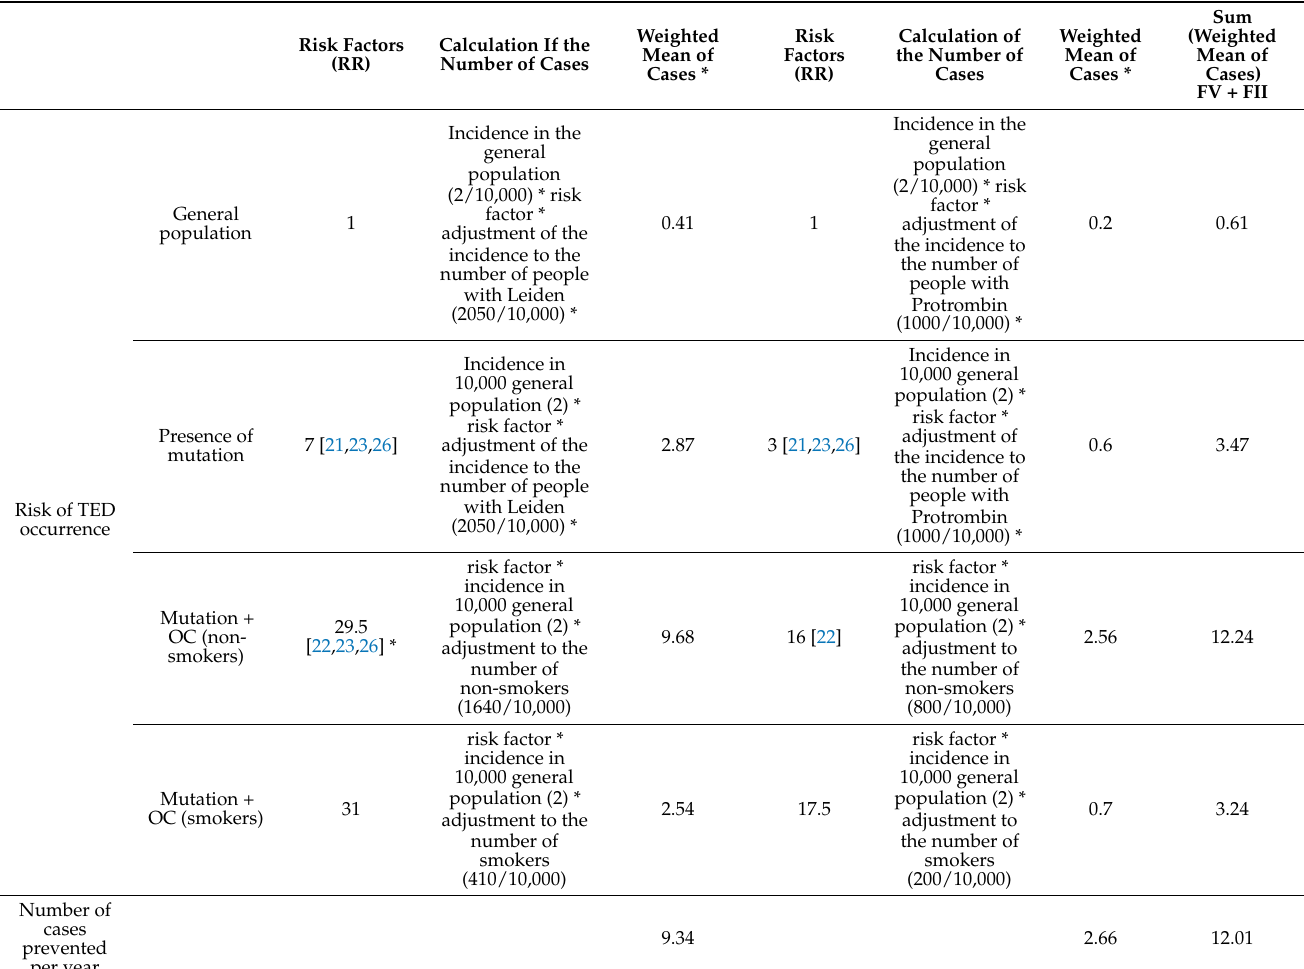
Table 2. Calculation of risk factors, incidences, and prevented cases at 100% compliance (i.e., if all women with a detected thrombophilic mutation restrain from taking OCs and cease